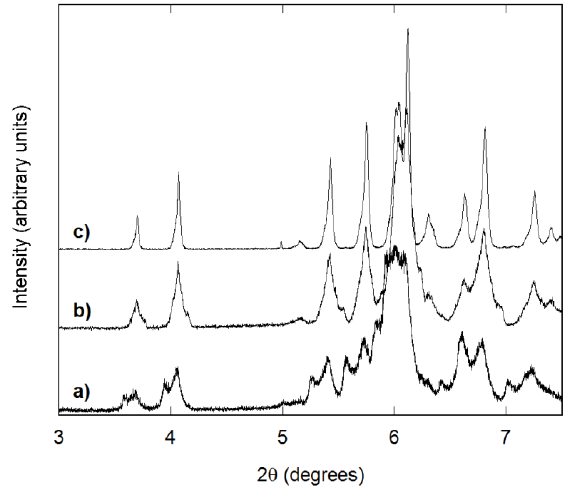
Figure 4. Synchrotron diffraction patterns of AlScMo 3 O 12 samples prepared in 10 mL of CHCl 3 by heating at 110 °C for: ( a ) 3 days; ( b ) 7 days; and ( c ) 12 days. All samples were crystallized at 700 °C for 3